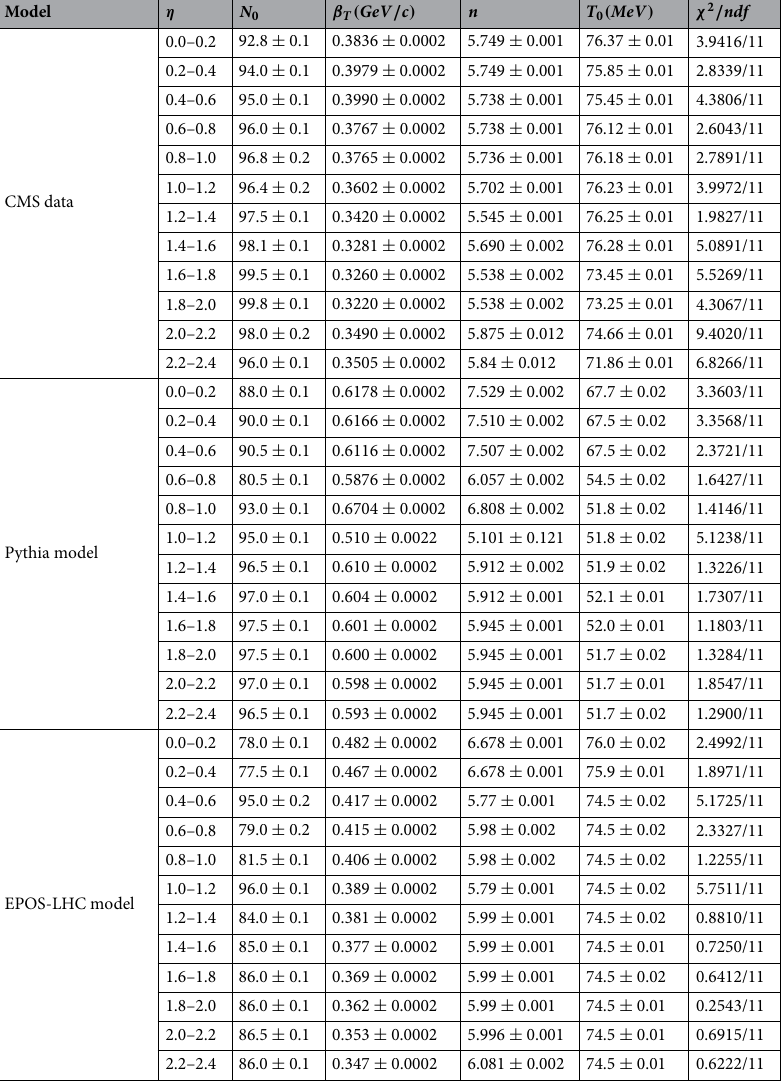
2 / ndf at different η